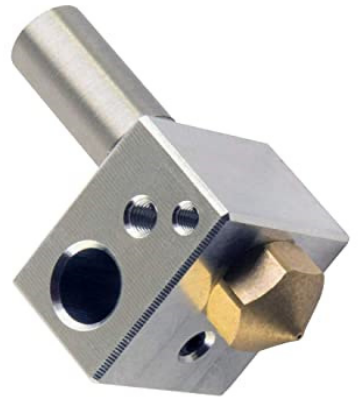
Figure 1. The commercially used